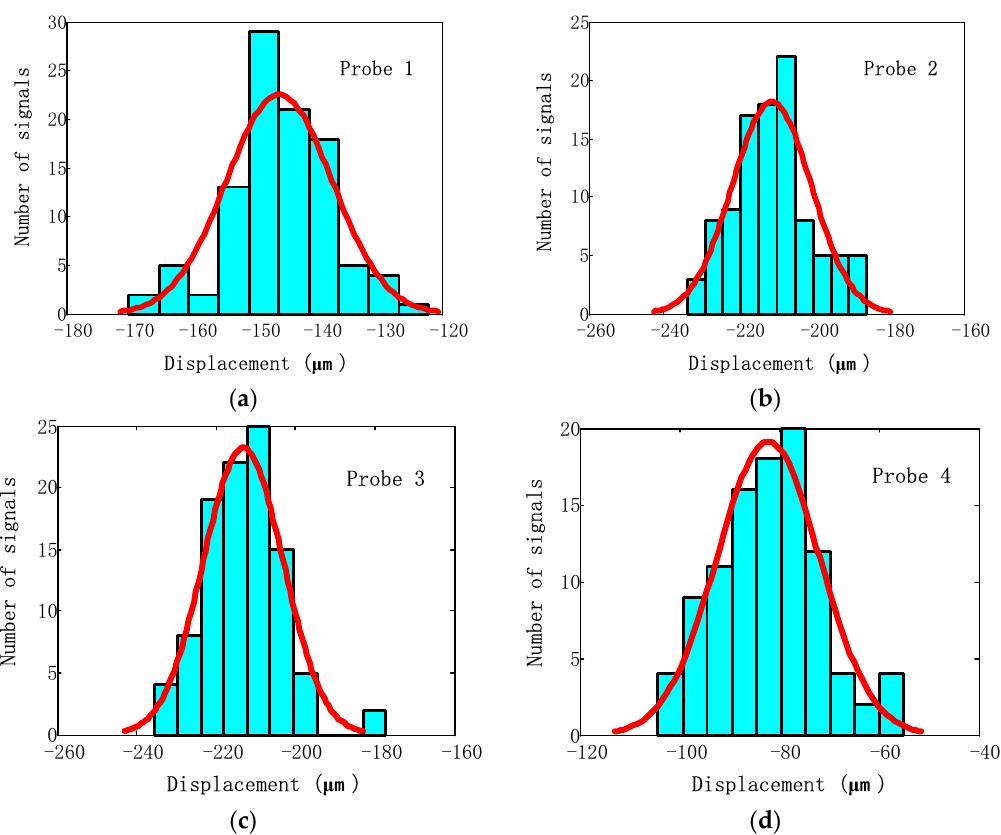
Figure 16. Distribution of signal sampled by ( a ) Probe 1 ( b ) Probe 2 ( c ) Probe 3 ( d ) Probe 4.